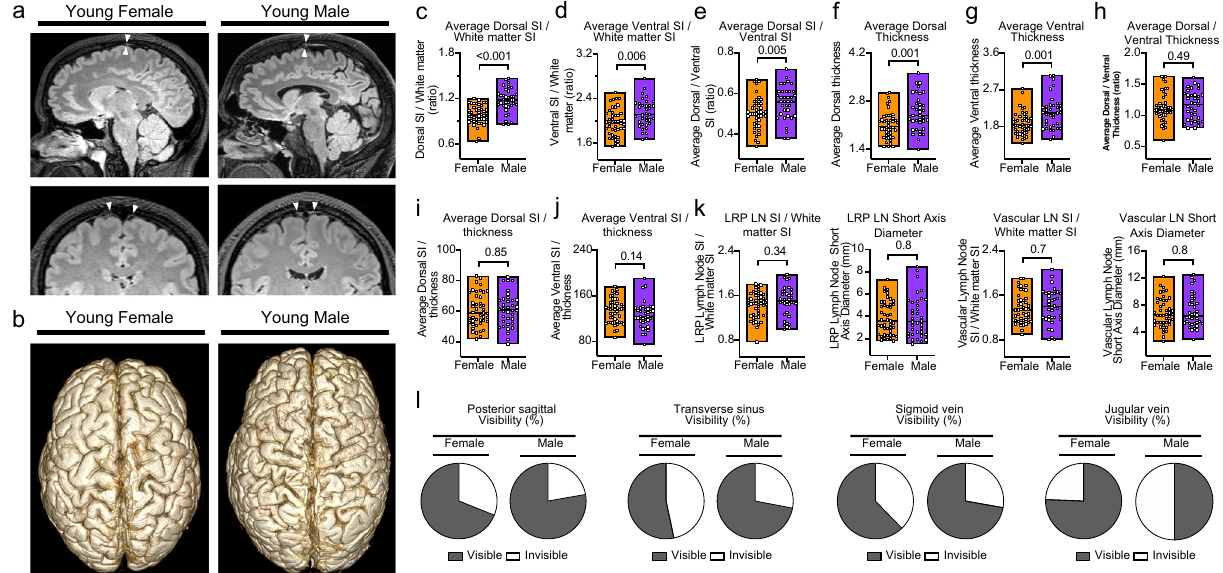
Fig. 7 Comparisons of the dorsal and ventral dural lymphatic system by sex. a Representative sagittal FLAIR images and coronal magni fi ed FLAIR images reveal increased thickness, extension, and SI of the parasagittal; dural lymphatics structures along the sagittal sinus (arrowheads) in the male subject compared to the female subject (both the male and female are young adults of the same age). b Comparisons of the 3D representation of dorsal dural lymphatics as de fi ned from T2-FLAIR shown from dorsal view. c – j Comparison of thickness and signal intensity values of dorsal and ventral lymphatic systems between male and female subjects. Student t test was used to compare older and younger age groups. All tests are two-sided. k Comparisons of retropharyngeal and vascular lymph node SI and short diameter by sex. Student t test was used to compare older and younger age groups. All tests are two-sided. l Comparison of visibility of dorsal lymphatics by sex. Data are presented as mean values ± SEM. [Female; N = 45], [Male; N =